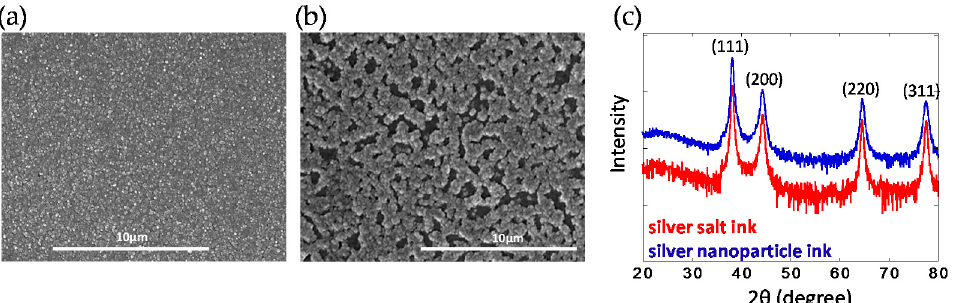
Figure 3. SEM images of the inkjet printed silver electrodes of TFTs by using ( a ) silver nanoparticles ink and ( b ) silver salt ink, respectively; ( c ) XRD patterns of the silver films after thermal treatment.